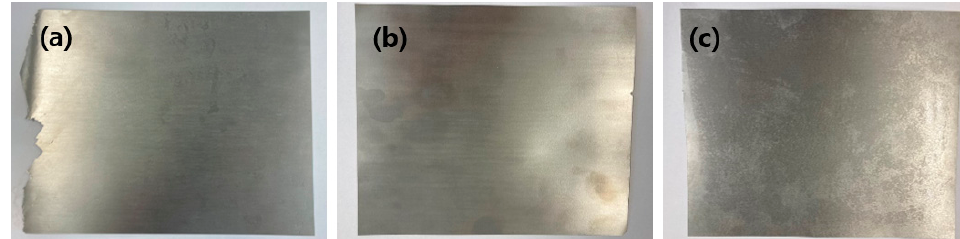
Figure 2. Tungsten plates. ( a ) A 0.3 ± 0.002 mm (42.5 g/cm 3 ) tungsten plate manufactured via hot rolling; ( b ) a 0.1 ± 0.001 mm (21.2 g/cm 3 ) tungsten plate manufactured via hot rolling; and ( c ) a 0.1 ± 0.001 mm (19.1 g/cm 3 ) plate manufactured via cold rolling.